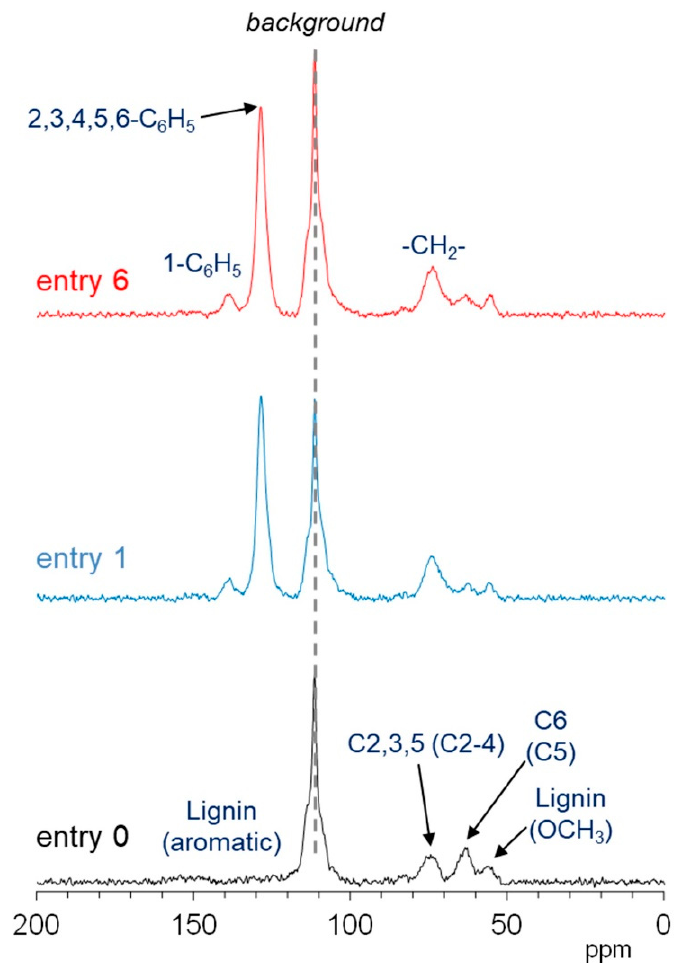
Figure 8. 13 C PST-MAS NMR spectra of degreased wood powder (entry 0, black) and benzylated wood powders (entry 1, blue; and entry 6, red).